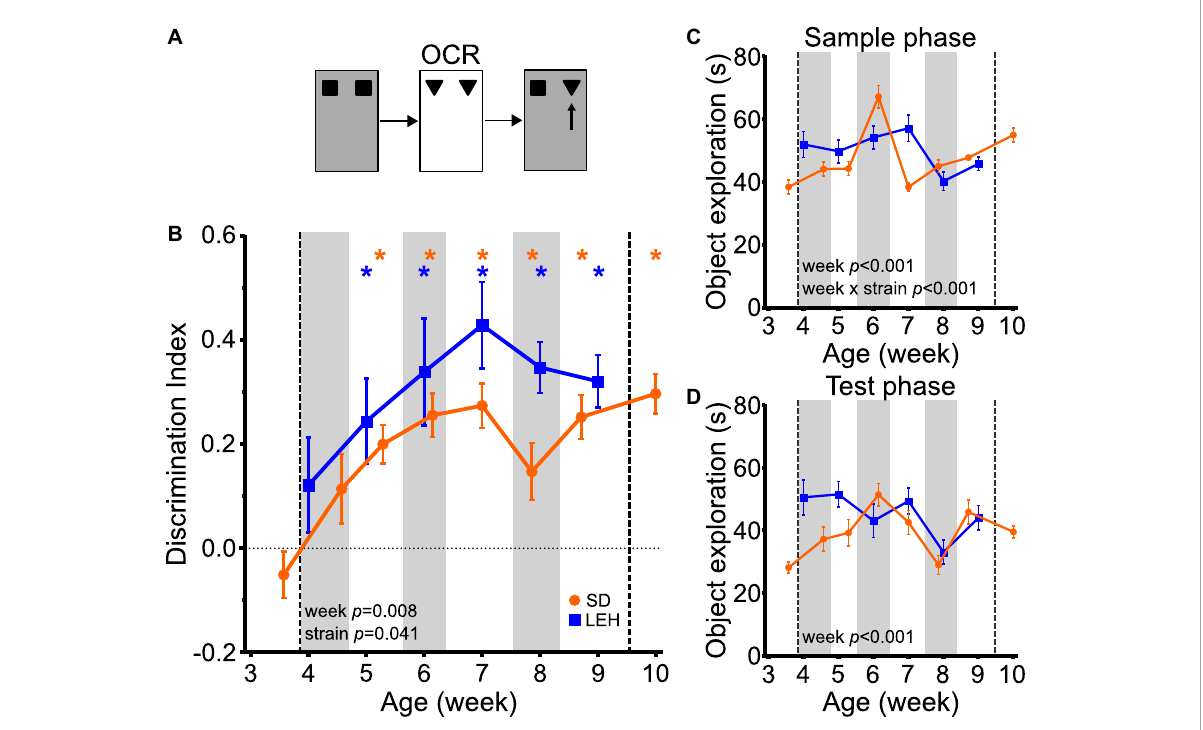
FIGURE3 Object-context recognition memory emerges at around 5 weeks of age in LEH and SD rats. (A) Schematic of object-context recognition task; (B) Object-context recognition memory performance, expressed as a discrimination index across development. Both LEH and SD rats show significant memory at all time points from the 5th week of age (P35 for LEH, P37 for SD). * p < 0.05. Significant main effect of week and strain were found; (C) Object exploration during the sample phases (mean in the two sample phases) for both LEH and SD rats. A significant main effect of week and a significant week × strain interaction were detected; (D) Object exploration during the test phase. A significant main effect of week was detected. [SD]: n = 16 for all time points; [LEH]: n = 13 except P49 where n = 12. For details on sample sizes, t , and p values for one-sample t -tests, see Supplementary Table 2 . Asterisks, shading on graphs etc., follow same convention as Figure 2